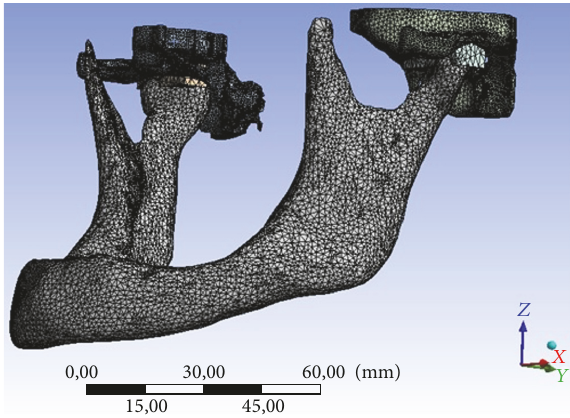
Figure 5: Tetrahedral mesh generated by ANSYS Workbench soft-